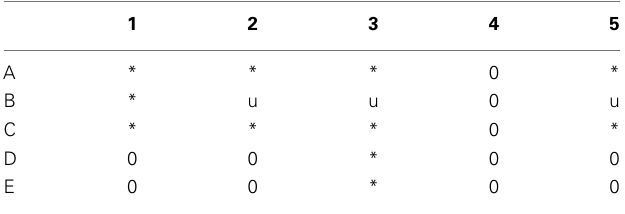
Table 1 | Summary of model behaviors for all cases.